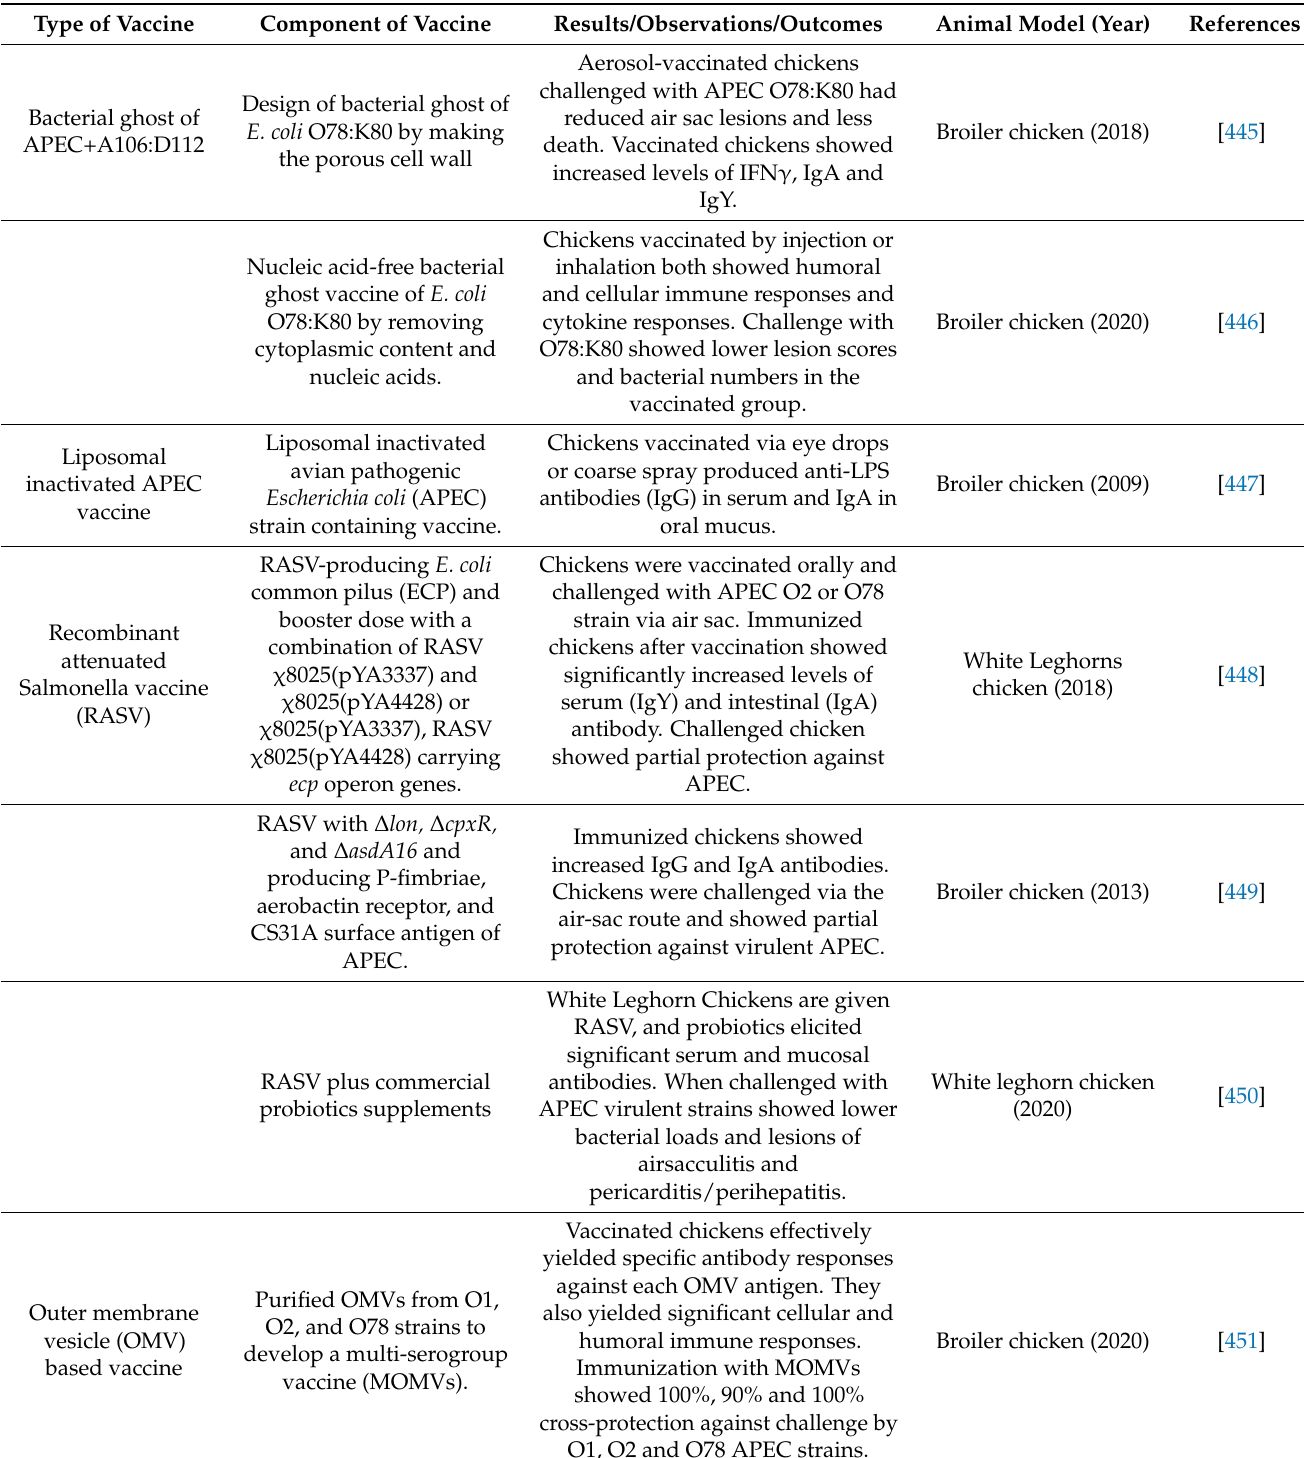
Table 6. Avian colibacillosis treatment/vaccine